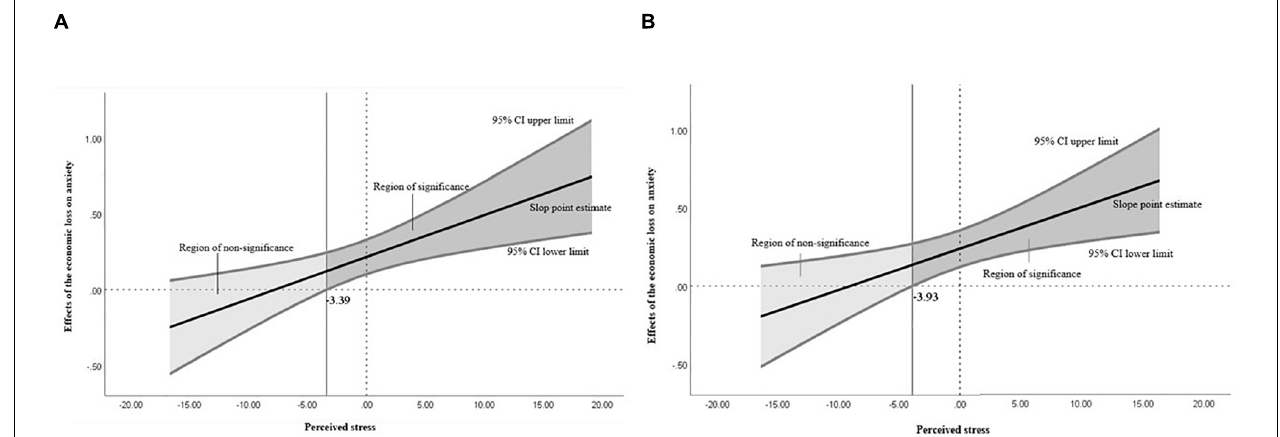
FIGURE 3 | Graphs of the moderation effect of perceived stress. (A) Johnson-Neyman analysis graph in the first survey; (B) Johnson-Neyman analysis graph in the second survey. TABLE 6 | The moderating effects of perceived stress on the relationship between economic loss and anxiety. Variables Anxiety (X1, X2) B SE